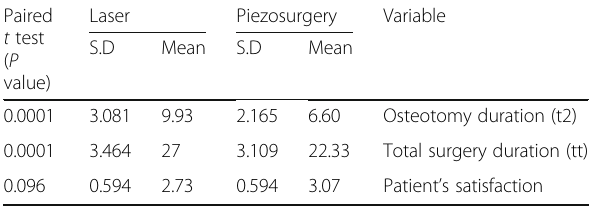
Table 4 Comparison of surgery duration and patient ’ s satisfaction in the two surgical techniques Paired t